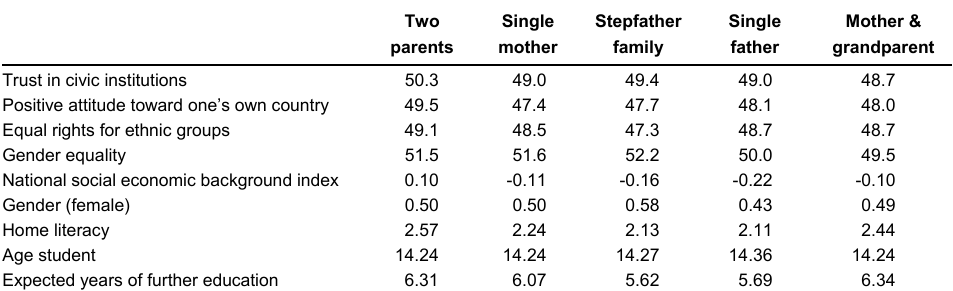
Table A3 : Descriptive statistics total population (N